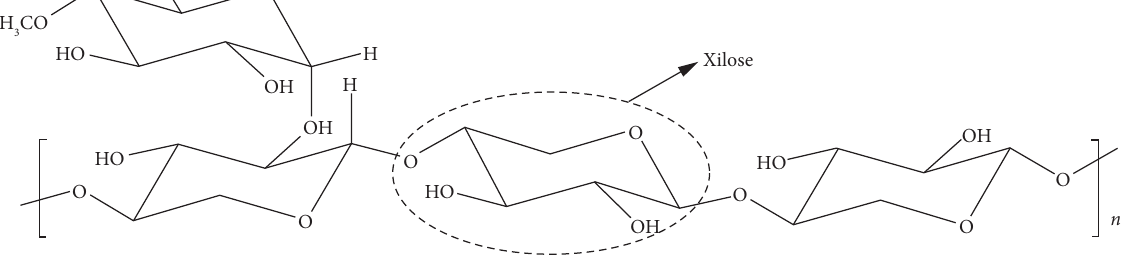
Figure 1: Chemical structure of hemicellulose [13].